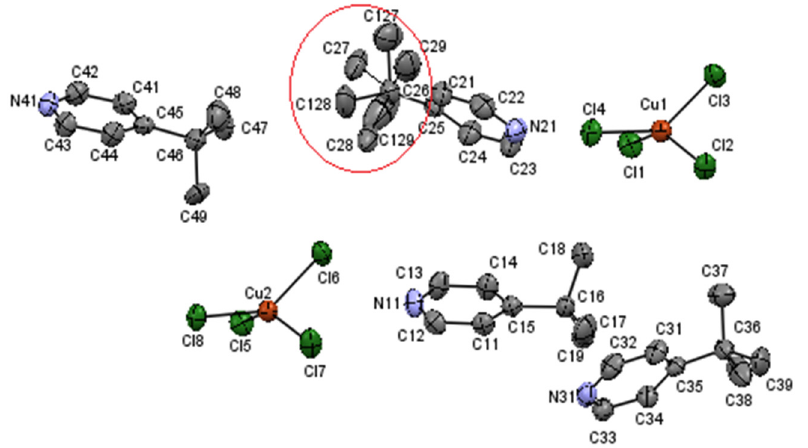
Figure 3. The ORTEP plot of (C 9 H 14 N) 2 [CuCl 4 ]; at the 50% probability ellipsoids, the displacement ellipsoids are drawn, highlighting the atom labeling scheme. The disordered components arecircled in red, with occupancies 0.586 (13)/0.414 (13) for C27/C127, C28/C128, and C29/C129. For clarity, the H-atoms have been eliminated.